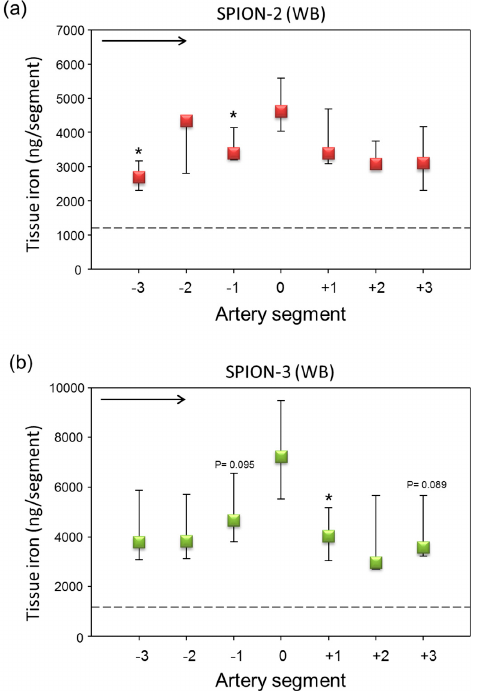
shows the representative histological images of the respective segments 0 under the magnetic tip, stained with Prussian blue.